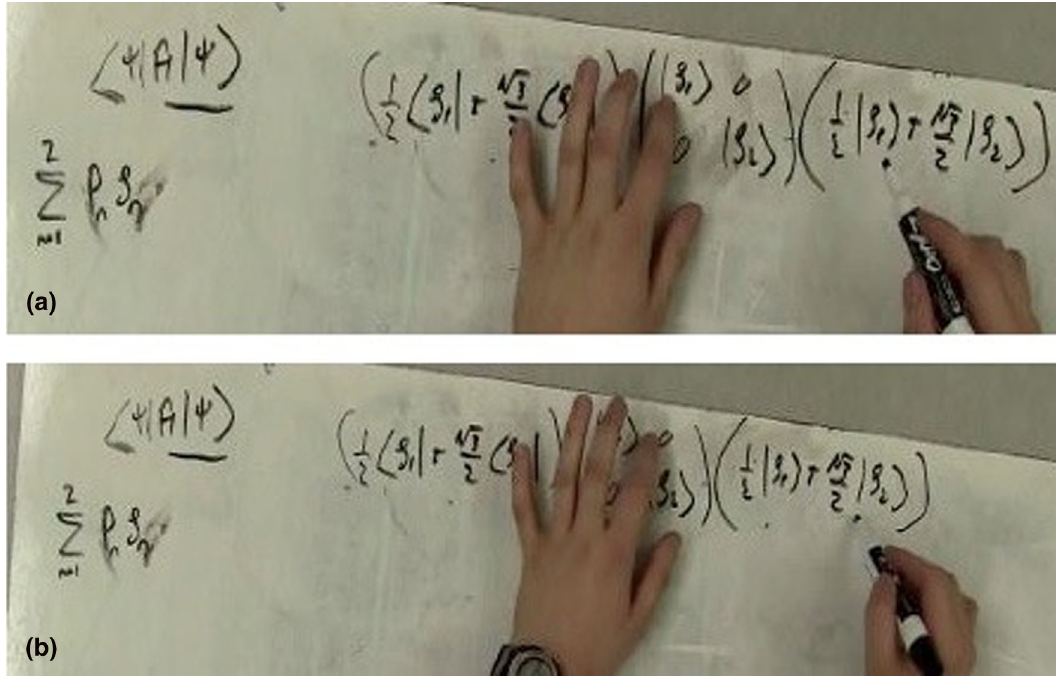
FIG. 4. (a) Calculation of energy expectation value in Dirac notation, but the student has written the Hamiltonian as a matrix and is attempting to perform matrix multiplication. In this picture, the student is multiplying to the H 11 and ψ 11 elements. (b) The student is continuing the “ matrix multiplication ” by multiplying the H 12 and ψ 12